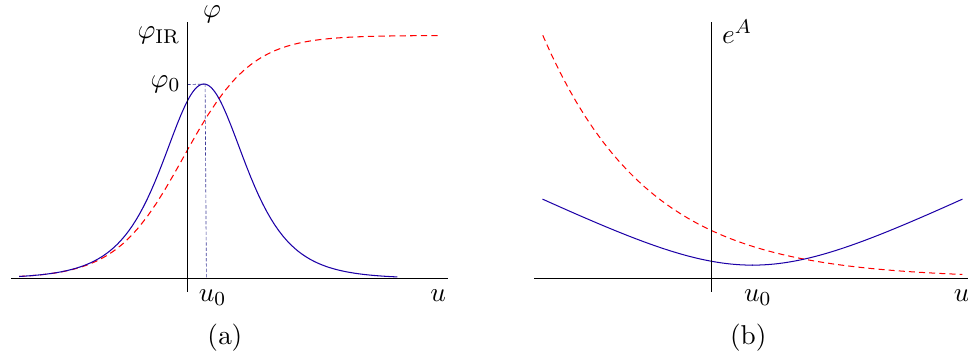
Figure 3 . The scalar (cid:12)eld (a) and scale factor (b) pro(cid:12)les of a negative curvature RG (cid:13)ow geometry (solid lines). Both the scale factor and the scalar (cid:12)eld have a turning point at the bottom of the throat, u = u 0 . The corresponding zero-curvature solutions extending to the conformal (cid:12)xed point ’ = ’ IR (dashed lines) are shown for comparison. The solution is symmetric around u 0